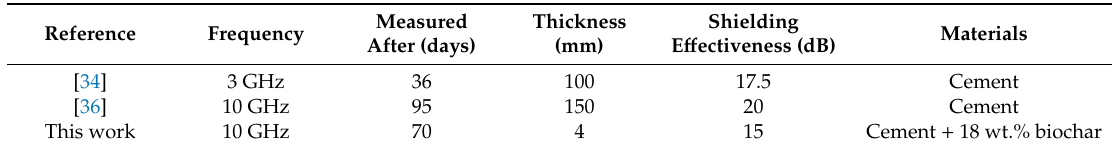
Table 2. Comparison with the literature.